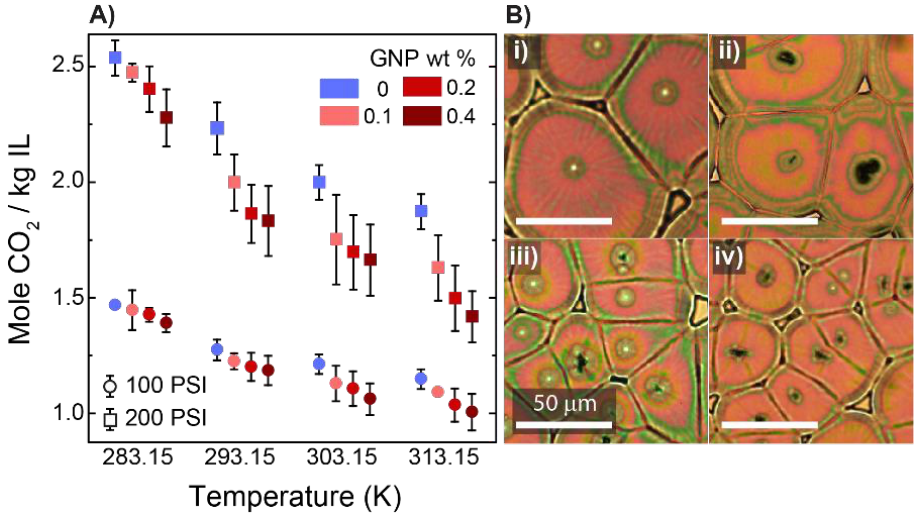
Figure 3. The effect of graphene nanoplate concentration on the properties of thin films. ( A ) The equilibrium absorption capacity of films at two different pressures of ( ⧮ ) 200 and ( ⧲ ) 100 psi. ( B ) Structural variation observed under polarized microscopy. Here, the concentrations of GNPs were: (i) 0, (ii) 0.1, (iii) 0.2, and (iv) 0.4 wt %. The control sample was a mixture of 50 wt % PVDF-HFP:IL to which various amounts of GNPs, as noted, were added. The error bar in Figure A represents the average values of CO 2 uptake for five different samples presented with one standard deviation. A scale is applicable to all panels of Figure 3B.